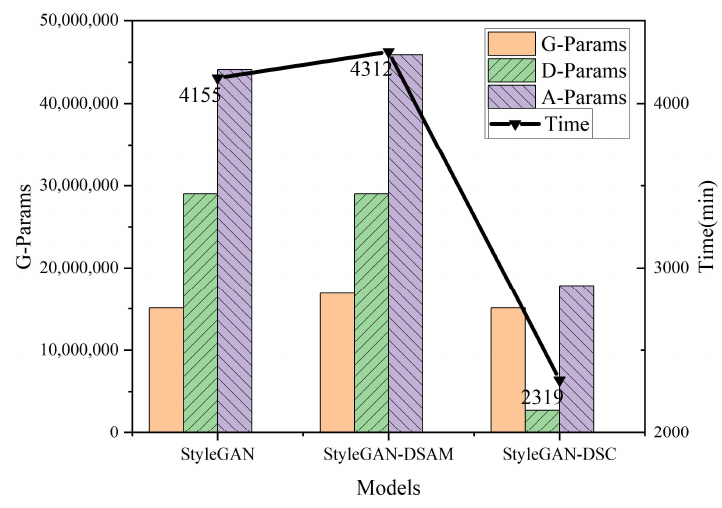
Figure 12. Comparison of model complexity.